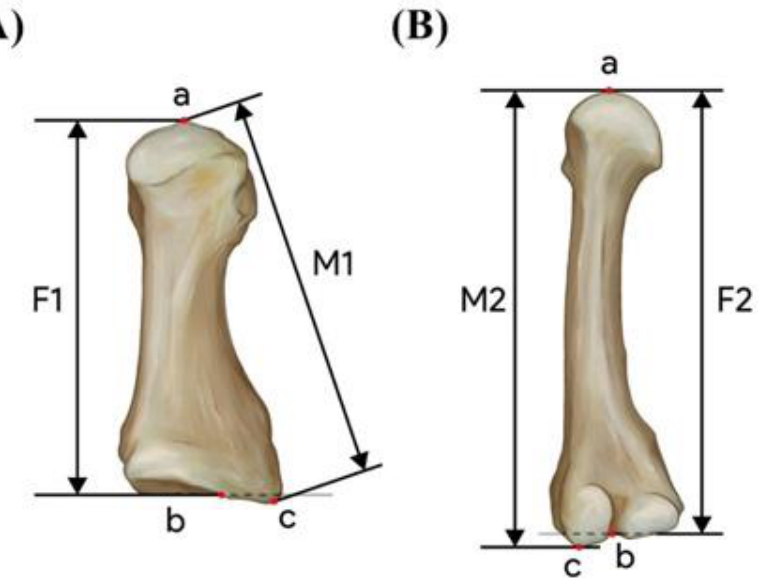
Figure 2. The measurements of metatarsal length. Metatarsal bones were observed superolaterally. ( A ) first metatarsal bone, ( B ) second metatarsal bone. F1, first metatarsal physiological length; F2, second metatarsal physiological length; M1, first metatarsal maximal length; M2, second metatarsal maximal length.